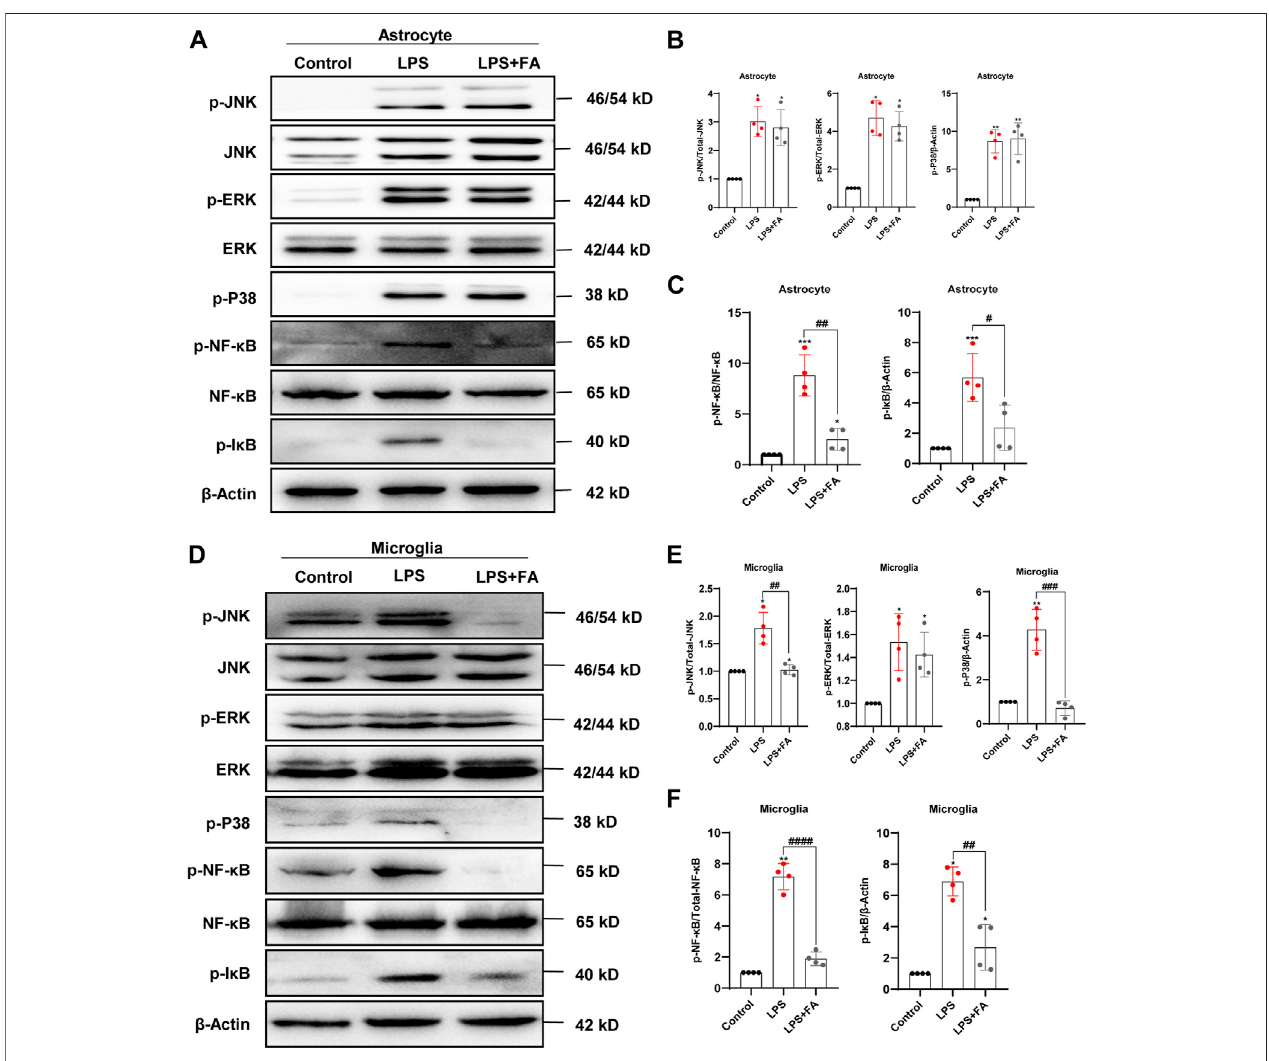
FIGURE5| FAregulatedtheexpressionlevelsofkeyproteinsinNF-kBandMAPKsignalingpathwaysinLPS-inducedastrocytesandmicroglia. (A) Representative Western blotting images of NF- κ B and MAPK signaling protein expressions in the primary astrocytes. (B,C) Quanti fi cation of the expression levels of proteins in (A) . (D) Representative Western blotting images of NF- κ B and MAPK signaling protein expressions in the primary microglia. (E,F) Quanti fi cation of the expression levels of proteins in (D) . Data: mean ± SEM; * p < 0.05, ** p < 0.01, *** p < 0.001 versus the control group; # p < 0.05, ## p < 0.01, ### p < 0.001, #### p < 0.0001 versus the PIA group; n = 4 per group (one-way